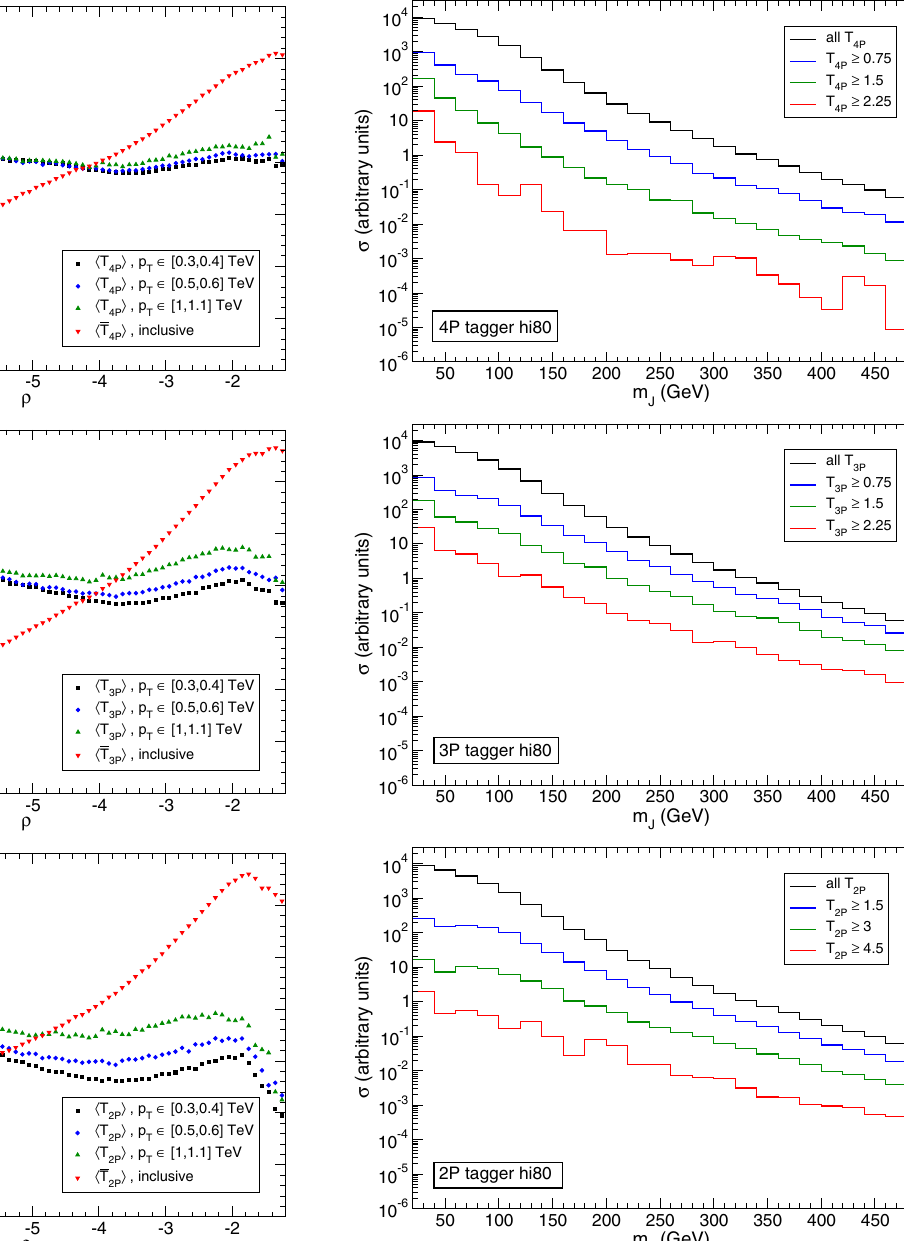
Fig. 1 Left: average (cid:3) T (cid:4) of the three mass-decorrelated hi80 taggers evaluated for the QCD background in three p T J bins, as a function of ρ . For comparison, the average (cid:3) ¯ T (cid:4) in the inclusive QCD sample is